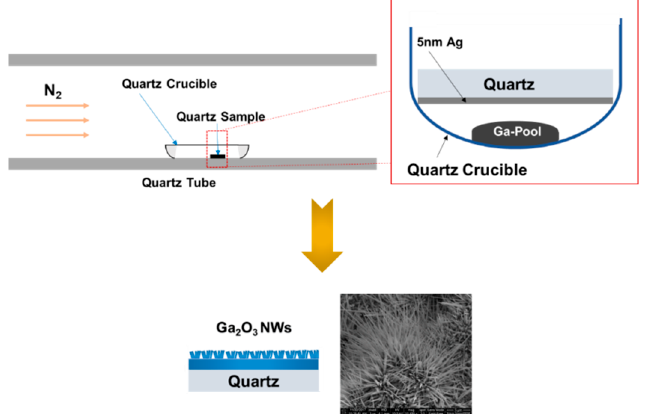
Figure 1. Schematic illustration of the fabrication process of Ga 2 O 3 nanowires by thermal growth process at 1000 °C in the presence of silver catalyst and liquid Ga, which was placed at the bottom of the quartz crucible.